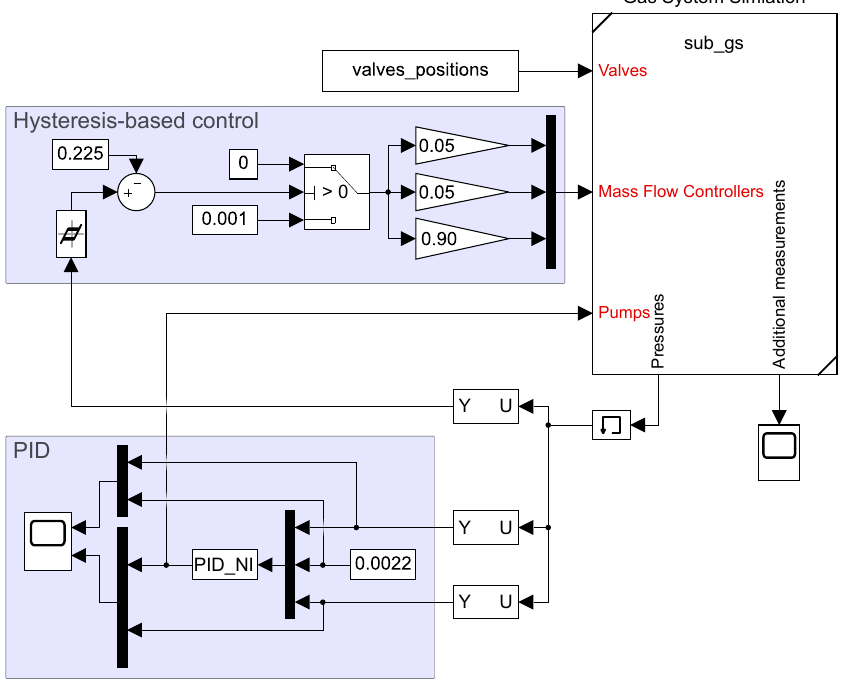
Figure 7. The control structure of the gas system used for recreation of the results obtained using the pilot gas